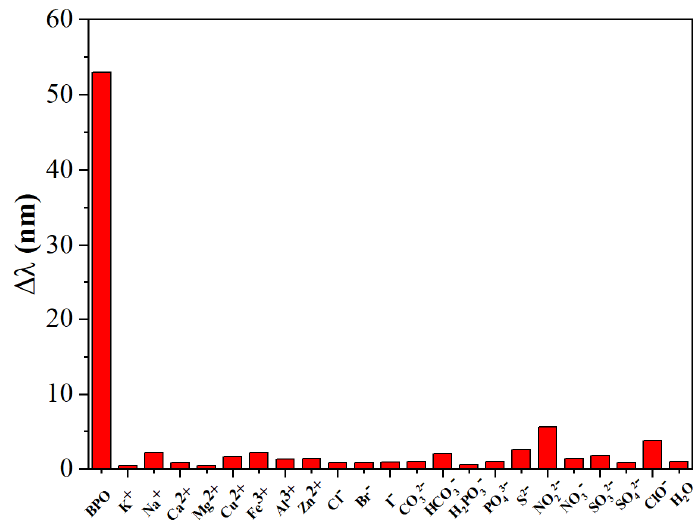
Figure 9. Sensing selectivity in the BPO determination. The mass concentration of the coexistence compounds from left to right were: 0.7 mg kg − 1 BPO, 5.3 g kg − 1 KCl, 5.3 g kg − 1 CaCl 2 , 10.0 g kg − 1 NaCl, 7.2 g kg − 1 MgSO 4 , 7.2 g kg − 1 MgSO 4 CuCl 2 , 7.2 g kg − 1 MgSO 4 FeCl 3 , 7.2 g kg − 1 AlCl 3 , 5.3 g kg − 1 KBr, 7.6